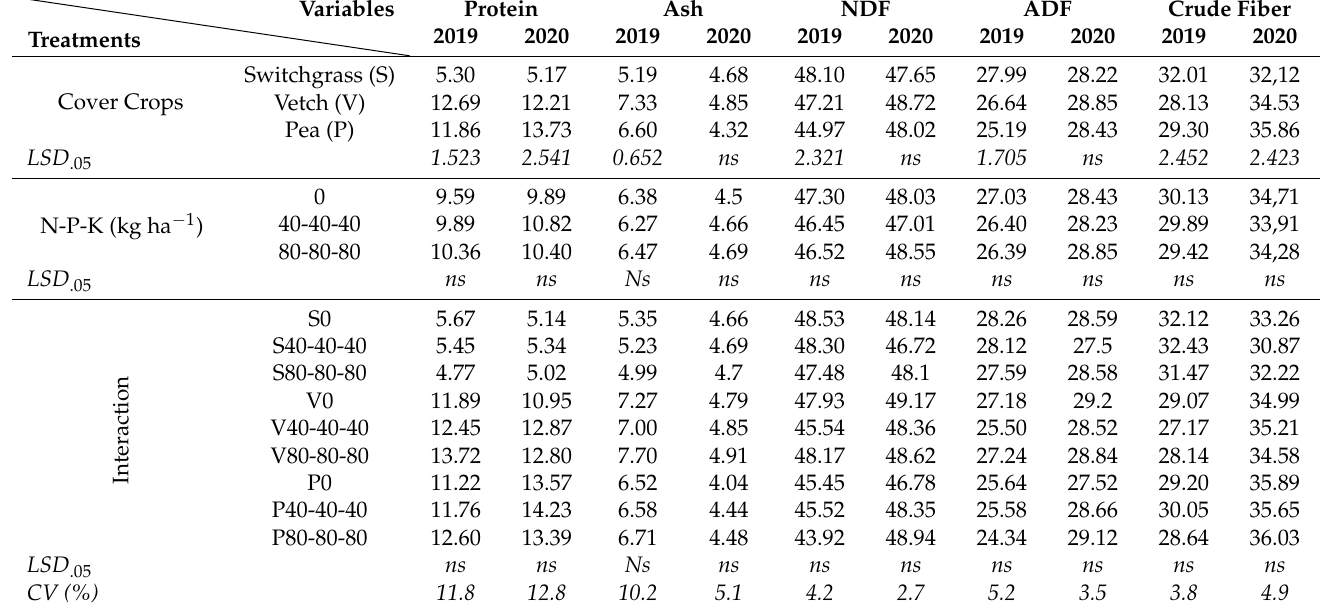
Table 2. Qualitative characteristics of switchgrass biomass in monoculture and co-culture of vetch or pea.